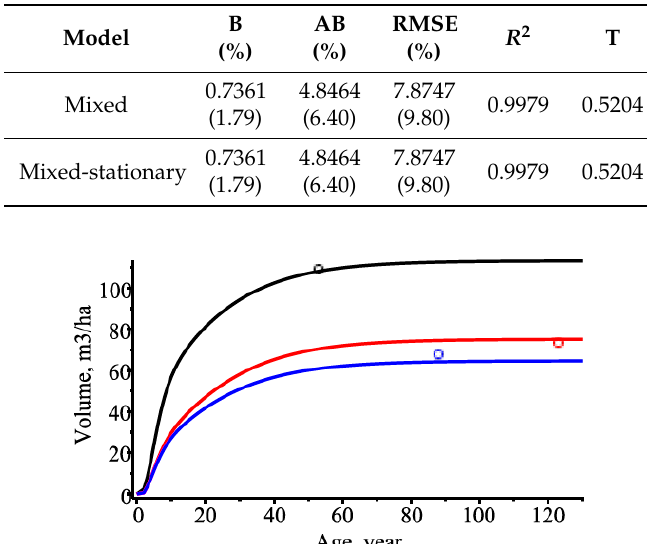
Table 16. Statistical measures and p -values of the Student’s t -test for the stand volume (m 3 / ha) (Equation (40)).